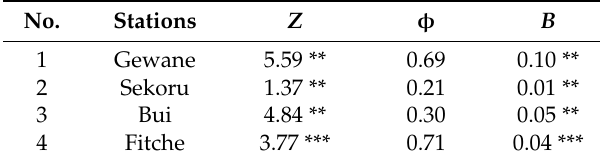
Table 6. Results of MK, ITAM, and Sen’s slope estimator tests for annual discharge. No.